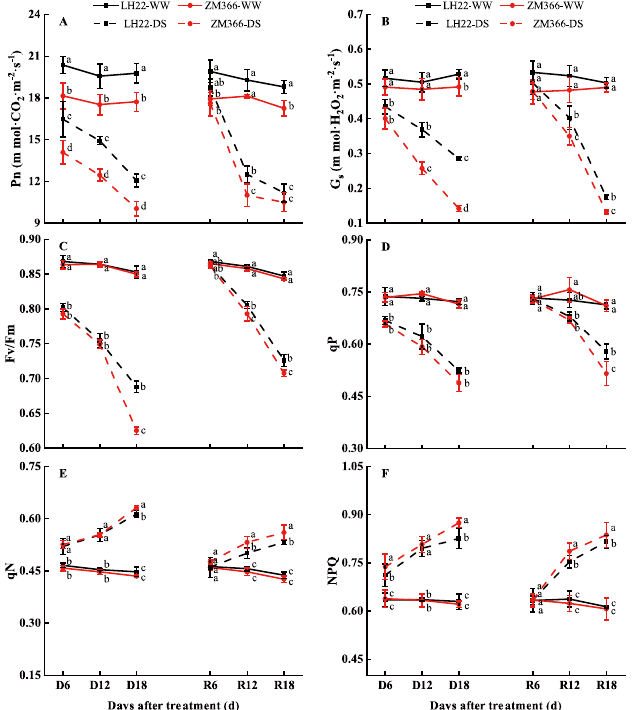
Figure 2. Effects of drought re-watering on ( A ) net photosynthetic rate (Pn), ( B ) stomatal conductance (G s ), ( C ) maximum photochemical quantum yield of PSII (Fv/Fm), ( D ) coefficient of photochemical quenching (qP), ( E ) coefficient of non − photochemical quenching (qN), and ( F ) non − photochemical quenching parameter (NPQ) of fl ag leaves of wheat at the booting stage. WW: well − watered; DS: drought stress; D 6, D 12, and D 18 indicate 6 d, 12 d, and 18 d of stress, respectively. R 6, R 12, and R 18 indicate re − watering after 6 d, 12 d, and 18 d of stress, respectively. Different lowercase letters in the same column indicate significant differences between the treatments (LH 22 − WW, ZM 366 − WW, LH 22 − DS, and ZM 366 − DS) at p < 0.05 (Duncan).